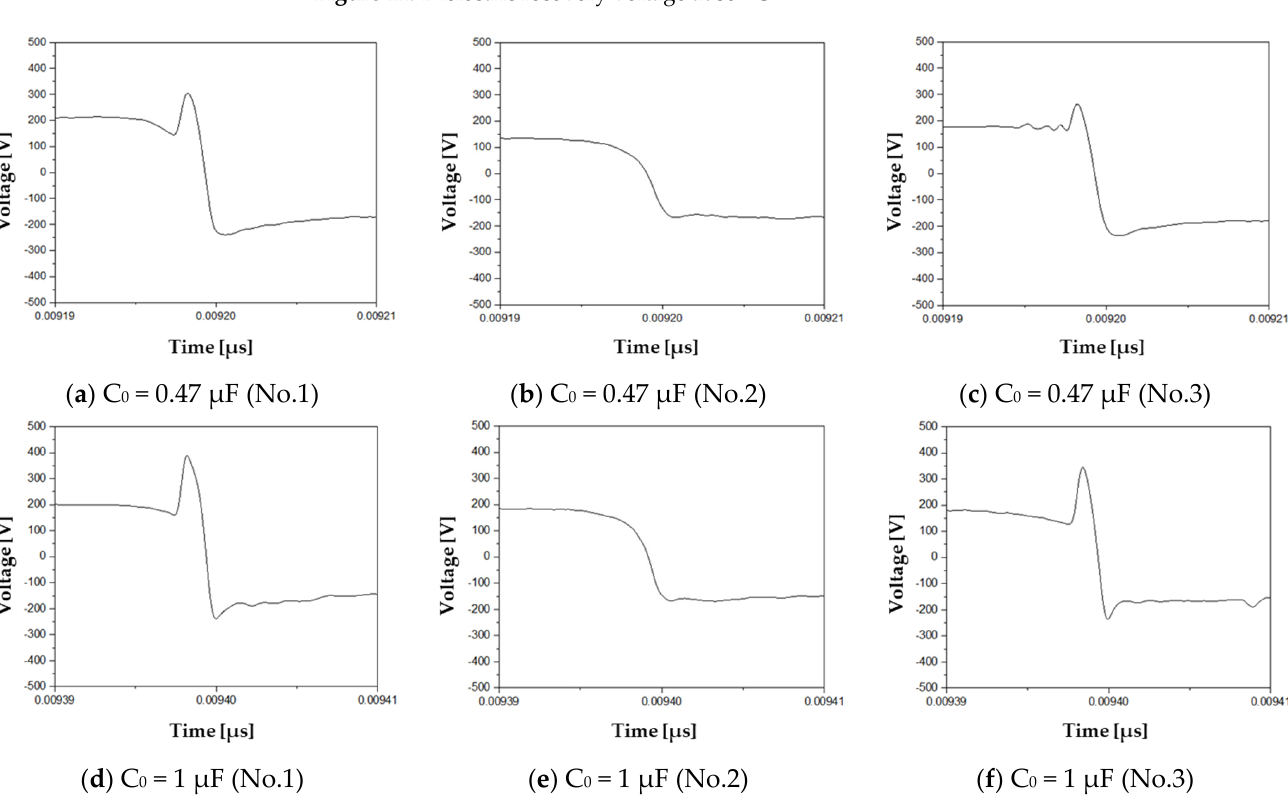
Figure 11. Dielectric recovery voltage at 35 °C.